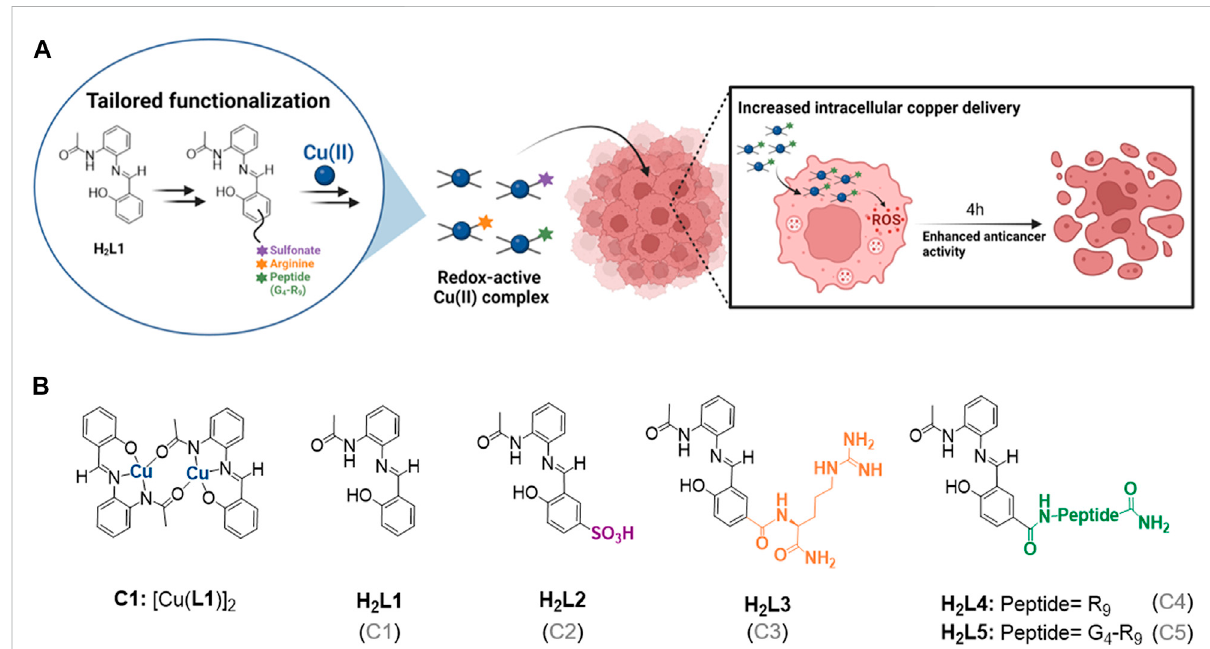
FIGURE 1 (A) Schematicrepresentationoftheworkrationale.Assessingtheimpactofthedifferentfunctionalizationsontheuptakeandanticanceractivity of Cu(II) complexes. (B) Structure of the Cu(II) complex C1 (Peña et al., 2021) and the different H 2 L1 functionalized ligands (H 2 L2-H 2 L5), where R and Ginthepeptidesstructurecorrespondtoarginine(Arg)andglycineaminoacids,respectively.ThenameoftheCu(II)complexcorrespondingtoeach ligand is speci fi ed in